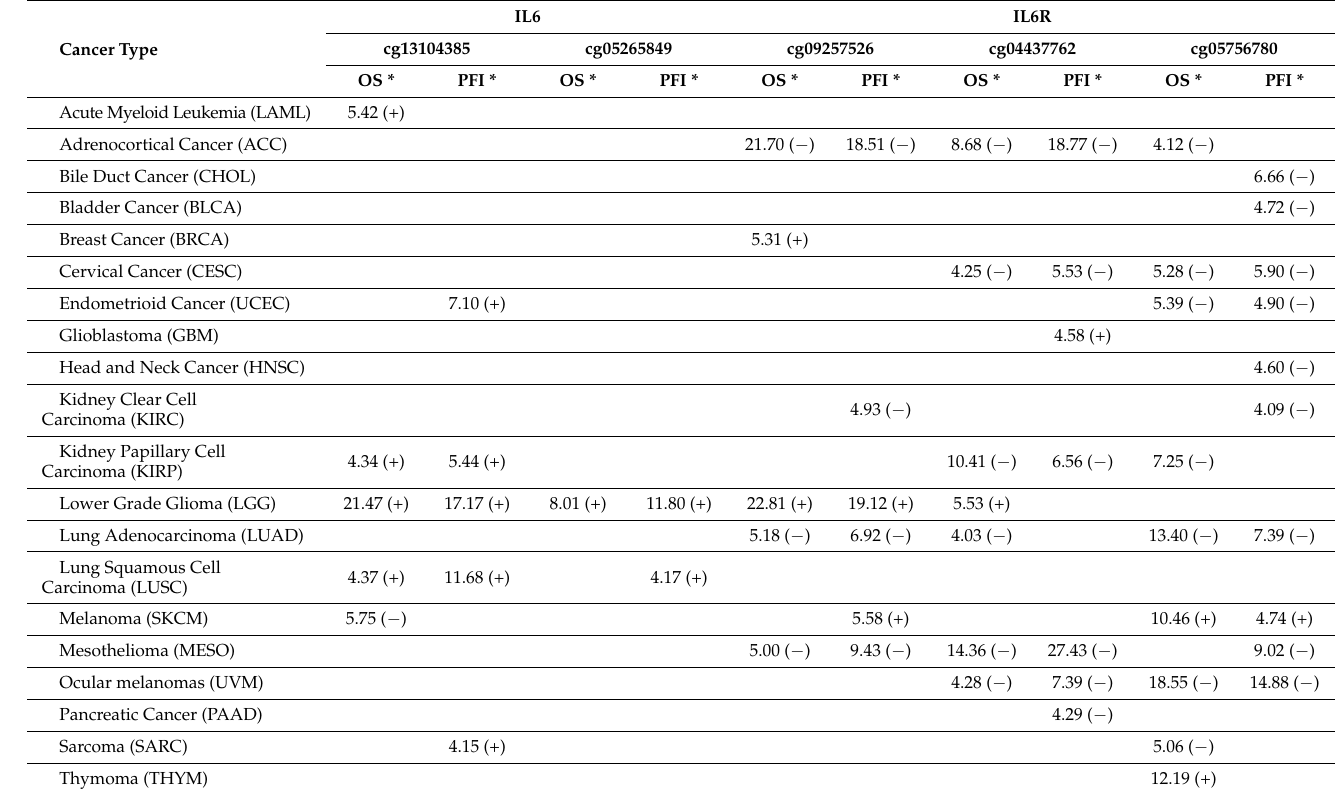
Table 2. Survival analysis of TCGA patients based on methylation status of selected IL6 and IL6R CG probesets.